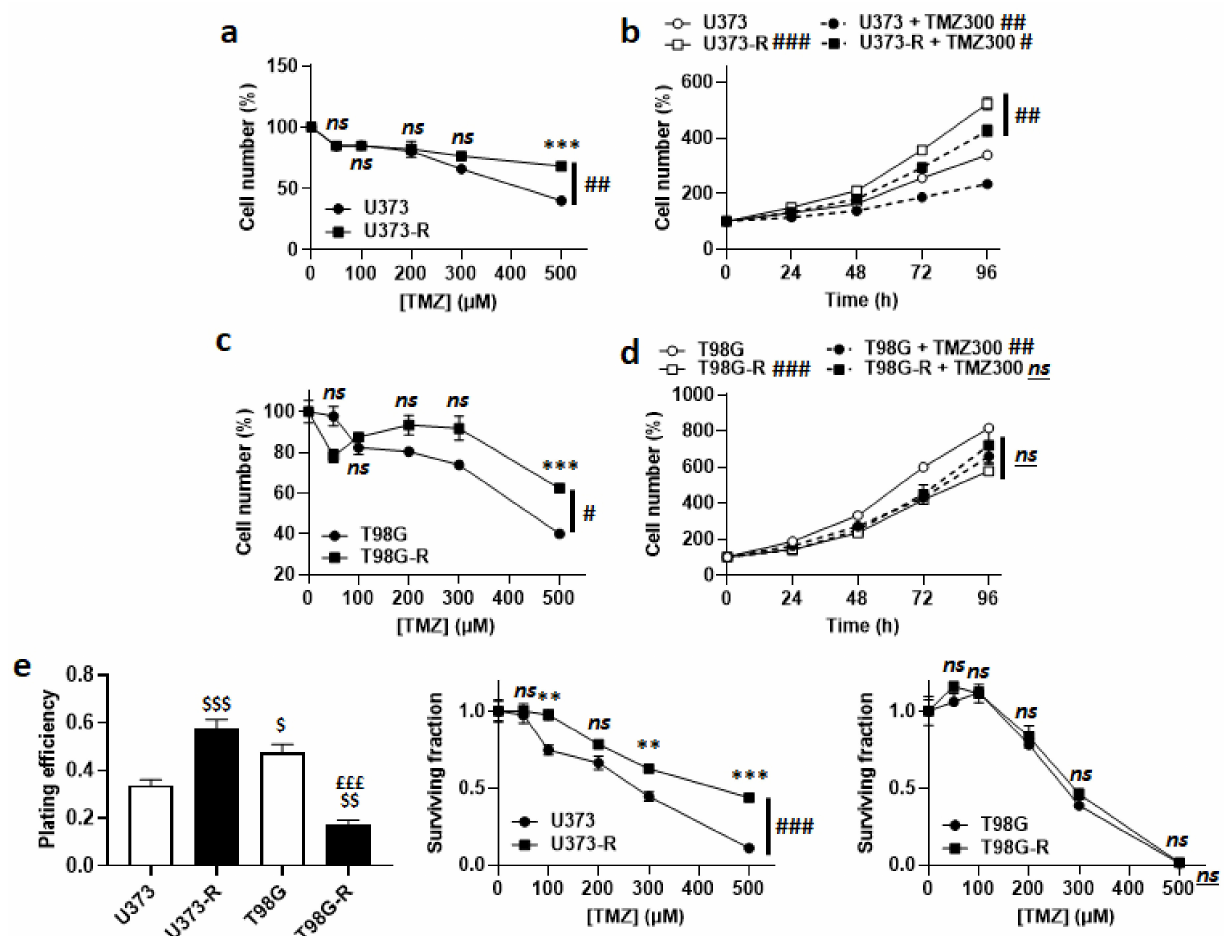
Figure 1. Validation of U373/U373-R as an isogenic model of TMZ-sensitive/resistant human glioblastoma cells. ( a ) Number of U373 and U373-R cells 72 h after treatment with the indicated concentrations of TMZ. For each curve, data are normalized to the number of the corresponding vehicle-treated cells ( n = 4). ( b ) Number of U373 and U373-R glioblastoma cells that were treated ± 300 µ M temozolomide (TMZ300) determined over time. For each curve, data are normalized to the number of corresponding cells at time 0 ( n = 4). ( c ) As in ( a ), but for T98G and T98G-R glioblastoma cells ( n = 4). ( d ) As in ( b ), but for T98G and T98G-R cells ( n = 4). ( e ) Clonogenic assays of U373, U373-R, T98G, and T98G-R cells that were pretreated for 72 h with increasing concentrations of TMZ. Displayed are the plating efficiency of vehicle-treated cells ( left ; n = 6); the surviving fraction comparing U373 with U373-R cells ( middle ; n = 6); and the surviving fraction comparing T98G with T98G-R cells ( right ; n = 6), where the data are normalized to the number of corresponding vehicle-treated cells. All data are shown as means ± SEM. ** p < 0.01, *** p < 0.005, ns: p > 0.05 versus the corresponding wild-type cells; # p < 0.05, ## p < 0.01, ### p < 0.005, ns: p > 0.05 for whole curve comparison; $ p < 0.05, $$ p < 0.01, $$$ p < 0.005 compared to the vehicle-treated U373 cells; £££ p < 0.005 compared to the vehicle-treated T98G cells; by two-way ANOVA with Sidak’s post hoc test ( a – d , e middle , e right ) or one-way ANOVA with Tukey’s post hoc test ( e